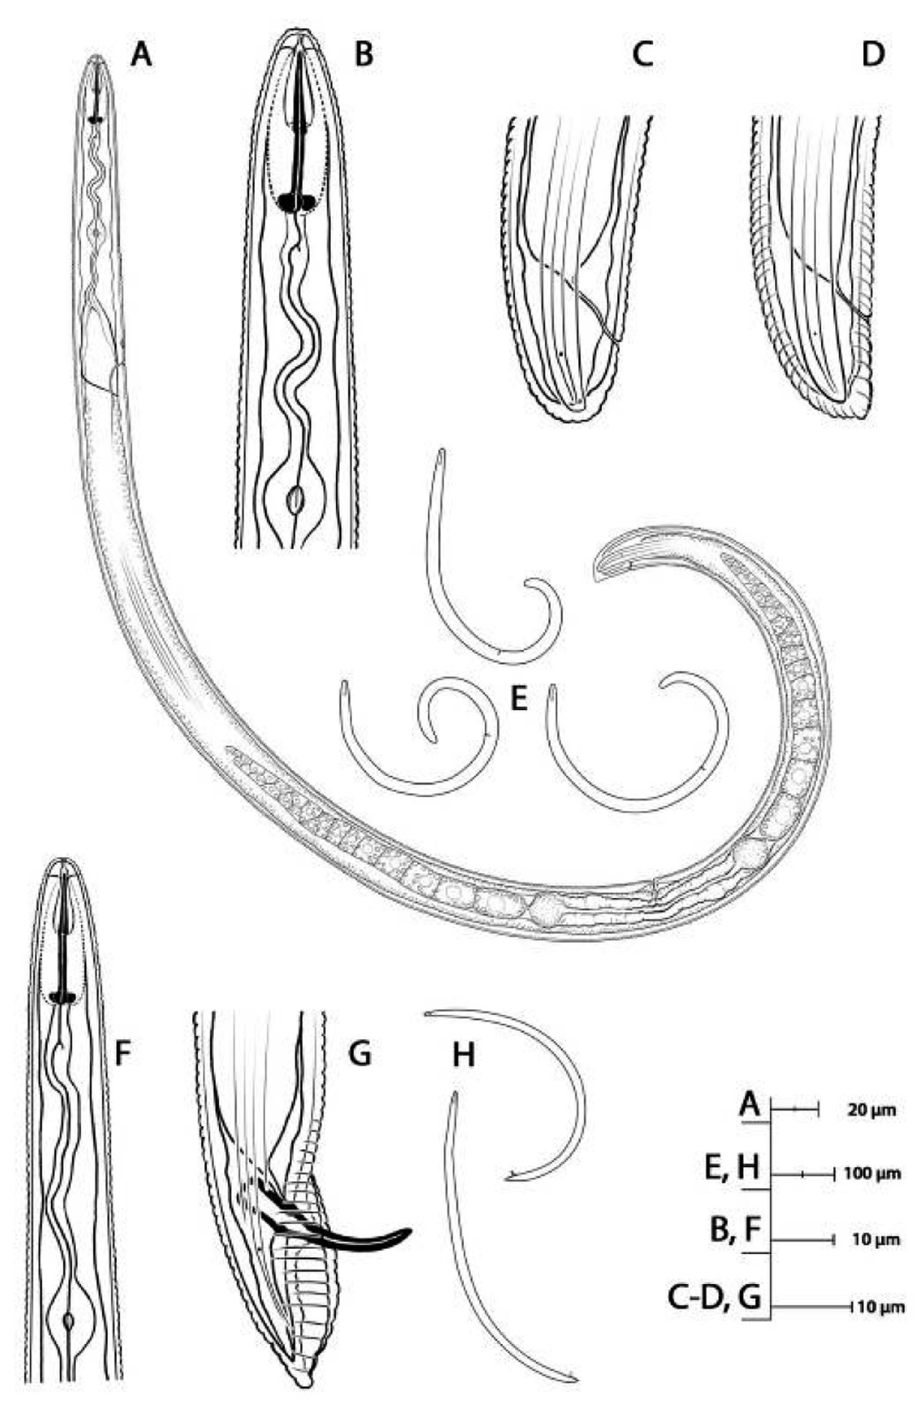
Figure 1. Helicotylenchus varicaudatus . Females (A–E). Whole female (A), head, lateral view (B), tails (C,D) and habitus (E). Males (F–H). Head, lateral view (F), tail, lateral view (G) and habitus (H). (Drawings by Fernando